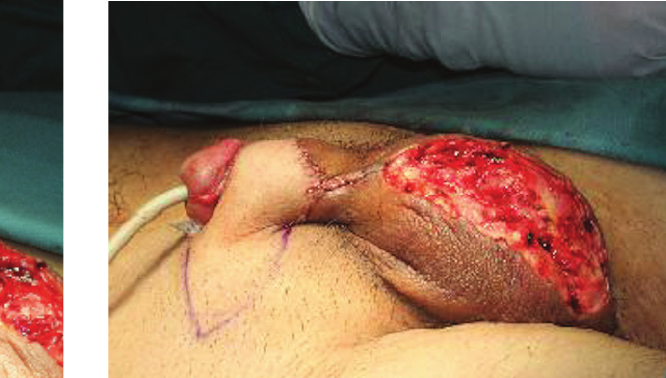
Figure 2 - Outlining the area of anterior abdominal wall for flap repair.